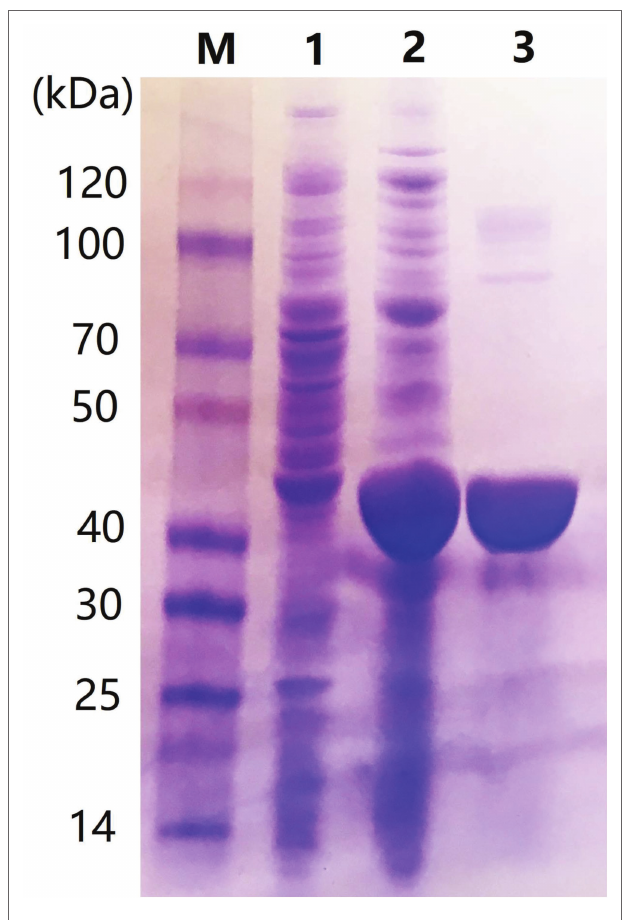
FIGURE 3 | Sodium dodecyl sulfate–polyacrylamide gel electrophoresis (SDS-PAGE) of purified recombinant Car1383. Lane M: Protein markers (BioRad, Hercules, CA, United States); Lane 1: supernatant of recombinant Eschericia coli BL21 (DE3) induced by IPTG for 16 h at 16 ° C; Lane 2: pellet fraction of recombinant E. coli BL21 (DE3) induced by IPTG for 16 h at 16 ° C; and Lane 3: purified